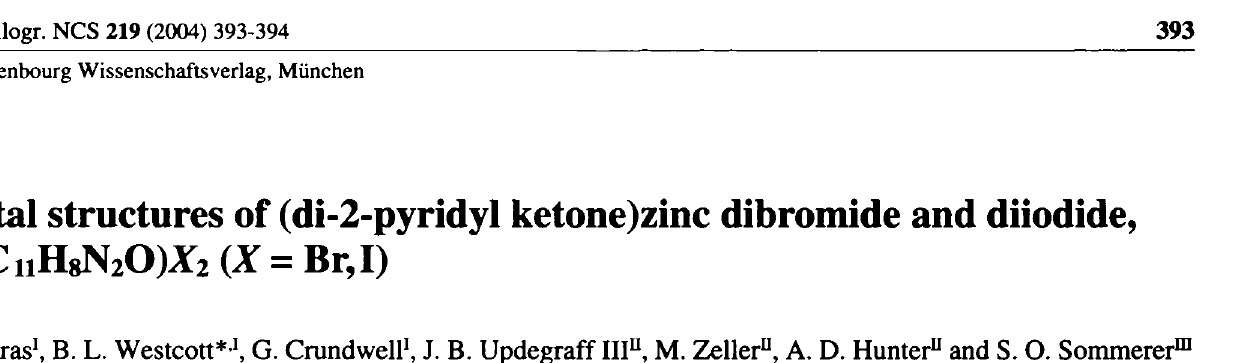
Zn—I); conversely, chlorine is the most electronegative of the three elements and thus the Cl-Zn-Cl angle is the largest (118.1°